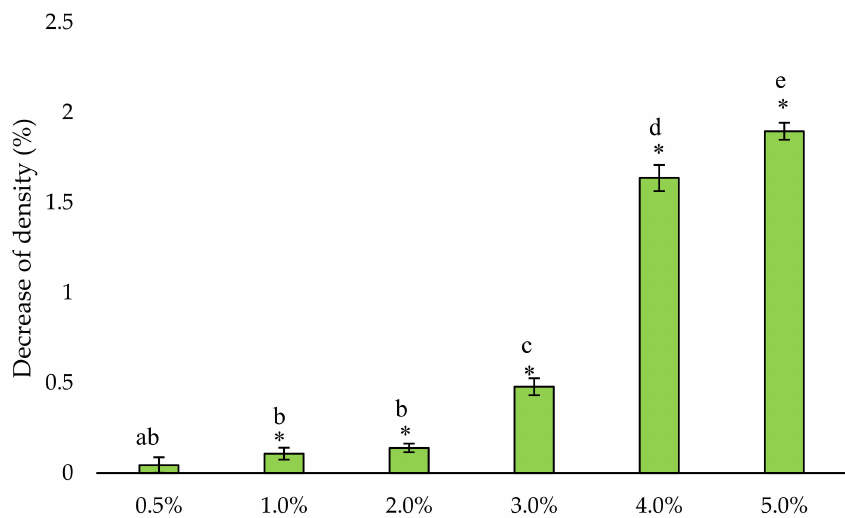
Figure 2. Density ( d ) for samples containing the biocide in a concentration from 0.5% to 5% (difference with the control—samples without biocide). Statistically significant differences from the controls are marked with an asterisk. Statistically significant differences between the variants are marked with separate letters.